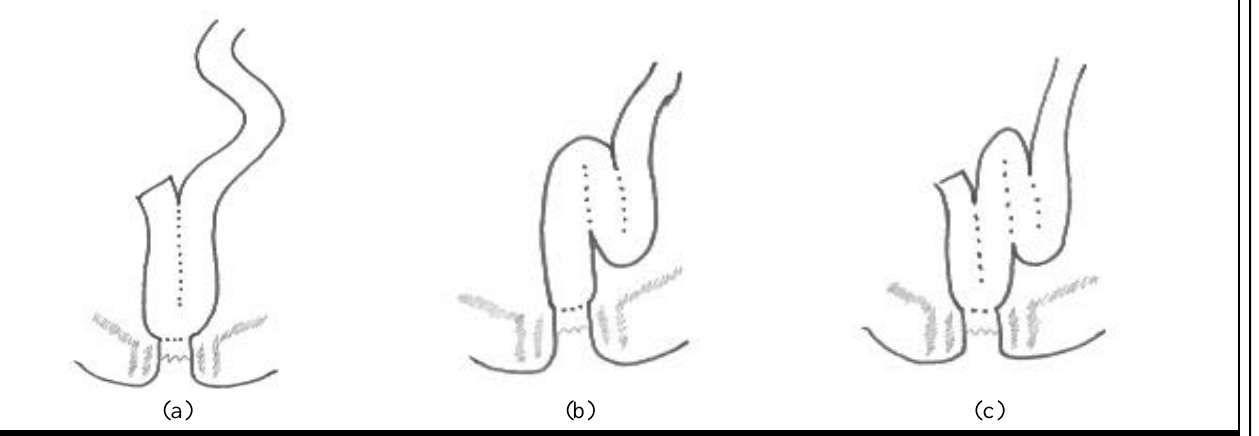
Fig.1 : The commonest configuration of ideal pouch is the J-pouch (a), which is most often stapled but may be hand-sewn. Others are the S-pouch (b) and the W-pouch (c), which are usually